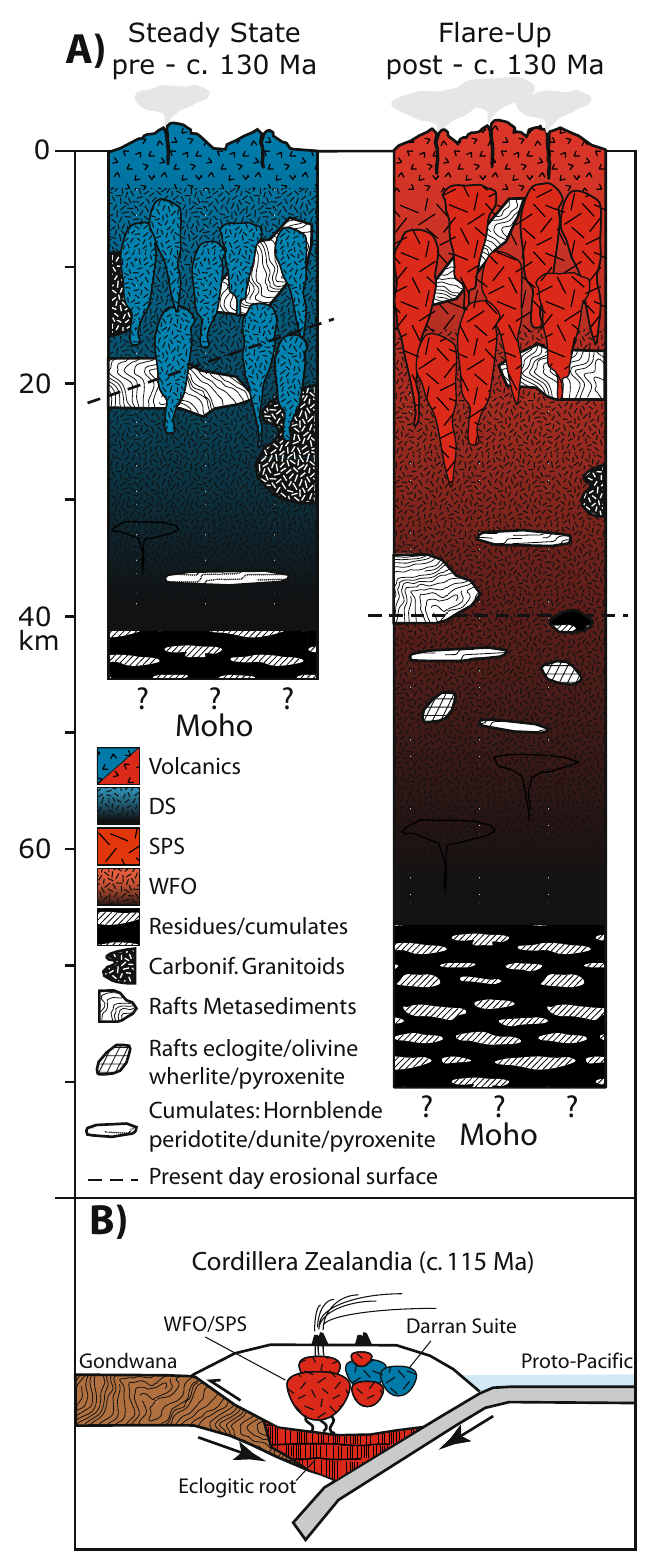
Figure 3. ( A ) Estimated crustal profile of the magmatic arc before and after c. 130 Ma. See Fig. 1. for abbreviations. (source data: Tulloch and Challis 44 ; Eberhart-Phillips and Reyners 45 ; Scott, et al. 29 ; De Paoli et al. 47 . Figure adapted from Tibaldi et al. 77 ). ( B ) Schematic cross section of Cordillera Zealandia showing the inferred under-thrust Gondwana margin converted to an eclogitic root following partial melting during a flare-up event, which produced the voluminous WFO and SPS suite